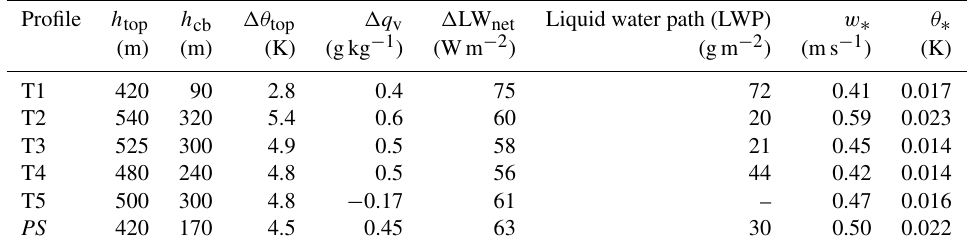
Table 1. The characteristics of the observed profiles on 5 June 2017.